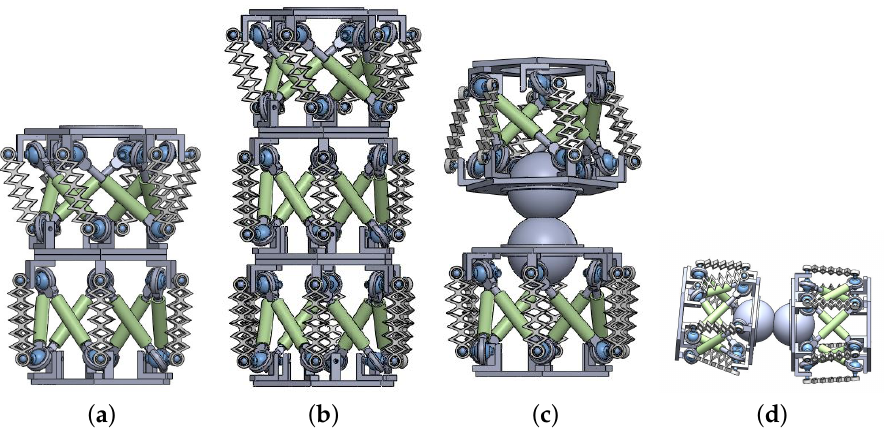
Figure 6. Nested links CAD prototype. ( a ) two-sections link. ( b ) three-sections link. ( c ) Two single links with a joint. ( d ) Two single links with a joint